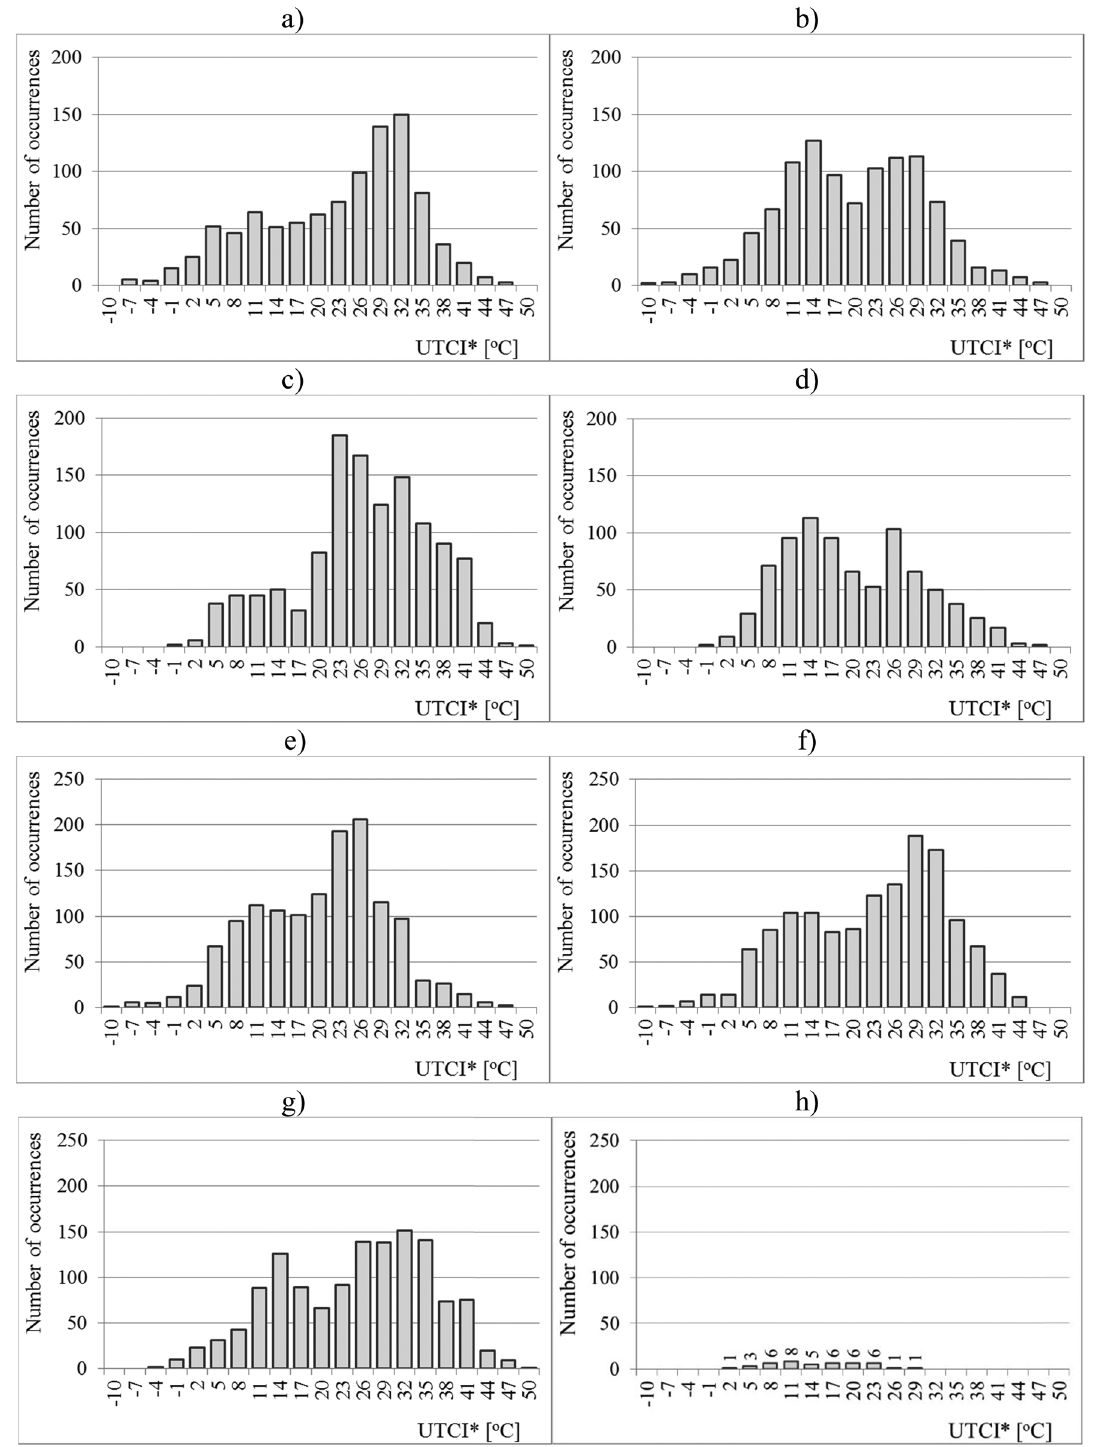
Figure 2: Histogram of UTCI ∗ on 40 sca ff olds measured for: ( a ) Lower Silesia, ( b ) Lublin, ( c ) Lodzkie, and ( d ) Masovian voivodeships at ( e ) 8 a.m., ( f ) 11 a.m., ( g ) 2 p.m., and ( h ) 5